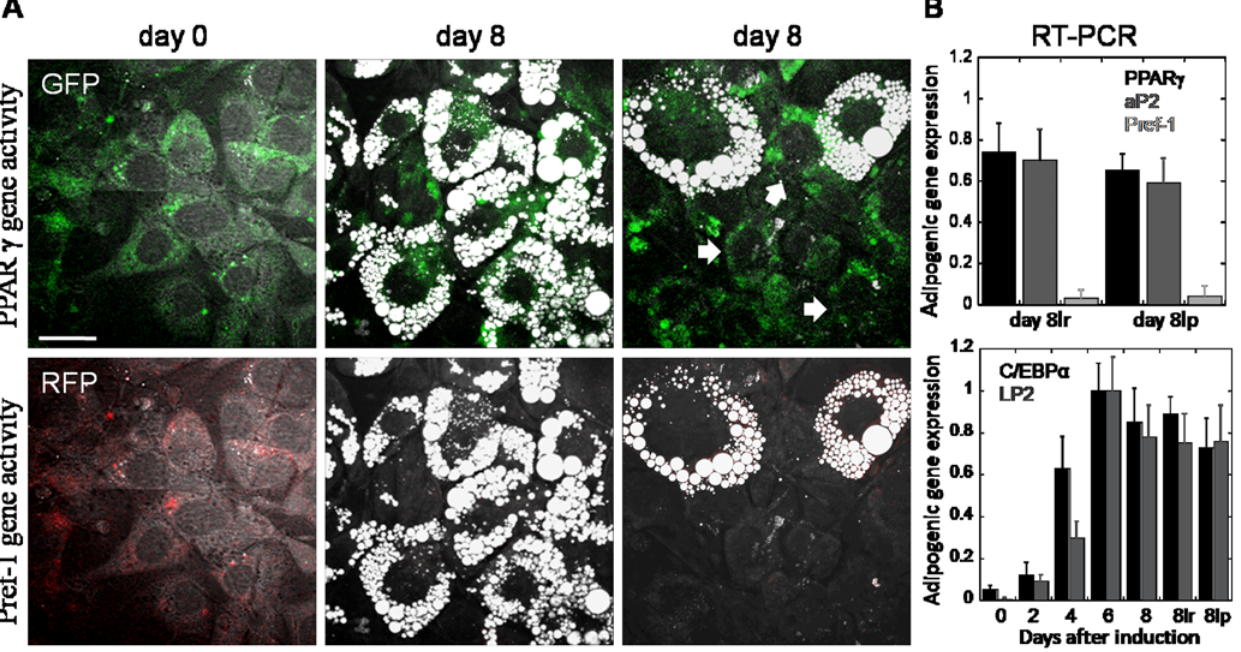
Figure 3. Increased adipogenic gene expression in both lipid-rich and lipid-poor cells. (A) Real-time visualization of PPAR c (upper panels, green) and Pref-1 (lower panels, red) gene activity using TPEF imaging of dsGFP (green) and dsRFP (red) signals at day 0 and day 8 after adipogenesis induction. Intracellular lipid droplets are visualized with CARS (grey) imaging. Arrows point to representative lipid-poor cells. Scale bar: 25 m m. ( B ) Real-time PCR gene expressions profiling of PPAR c , aP2, and Pref-1 gene activity (upper panel), and C/EBP a and LP2 gene activity (lower panel). PPAR c and C/BEP a are transcription factors whose expressions are critical for early-stage differentiation of 3T3-L1 cells. aP 2 and LP2 are lipid-binding proteins whose expression are controlled by PPAR c . aP2 and LP2 expressions mark late-stage differentiation of 3T3-L1 cells. Pref-1 is a preadipocyte marker protein whose down-regulation is required for adipogenesis. 8lr and 8lp represent sorted lipid-rich and lipid-poor populations at day 8 after adipogenesis induction, respectively. Error bars represent distribution across 4 repeated experiments.